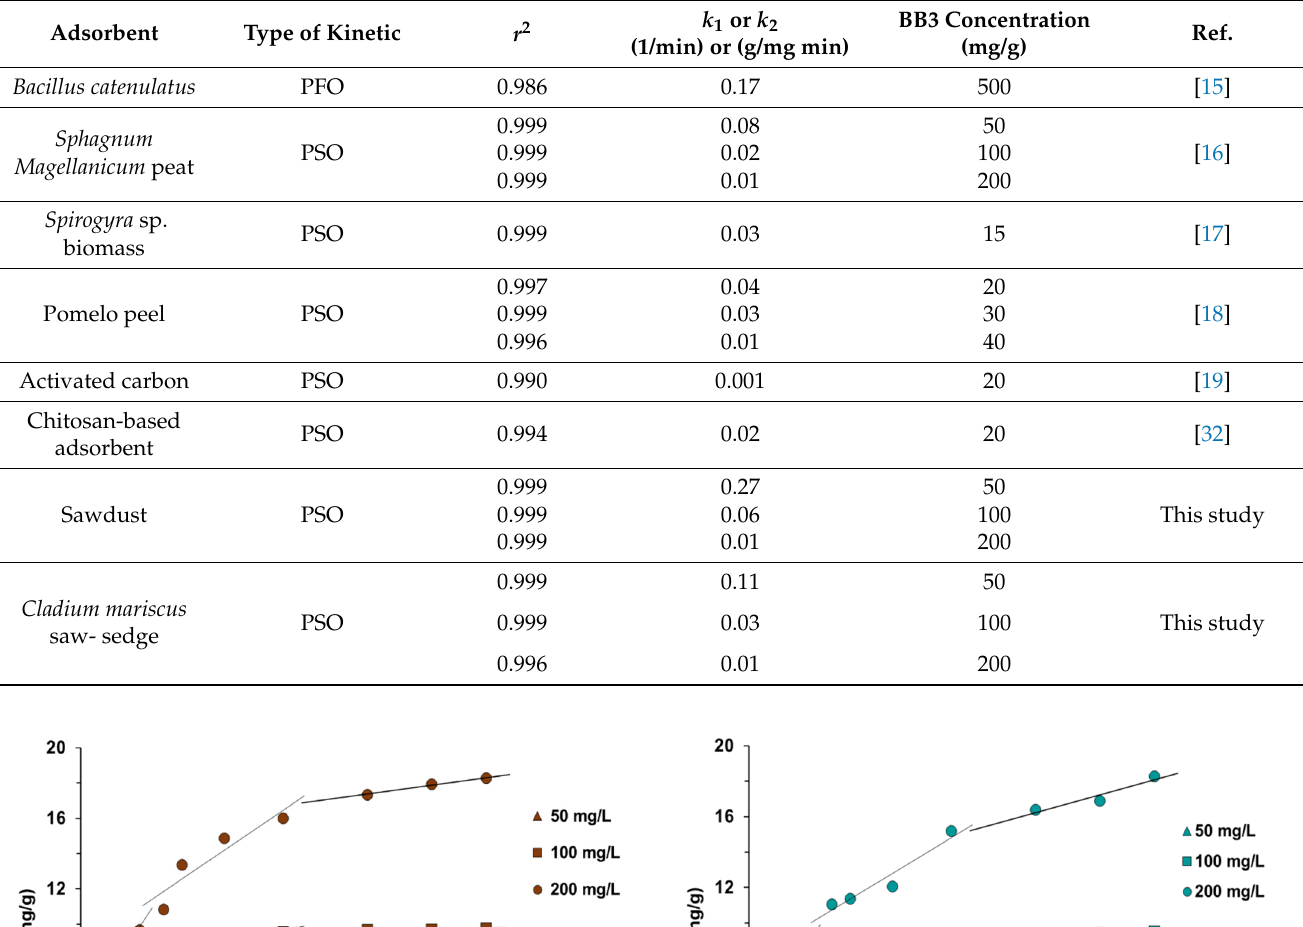
Table 3. The kinetic parameters describing the adsorption of BB3 on the selected adsorbents.